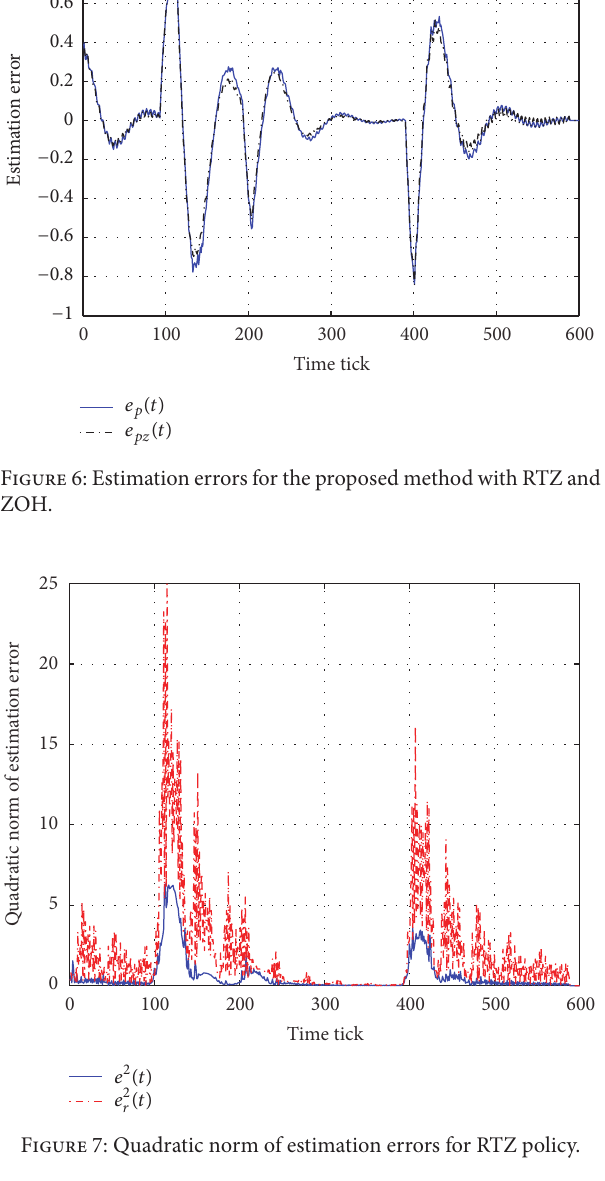
with less estimation error. The simulation results are not